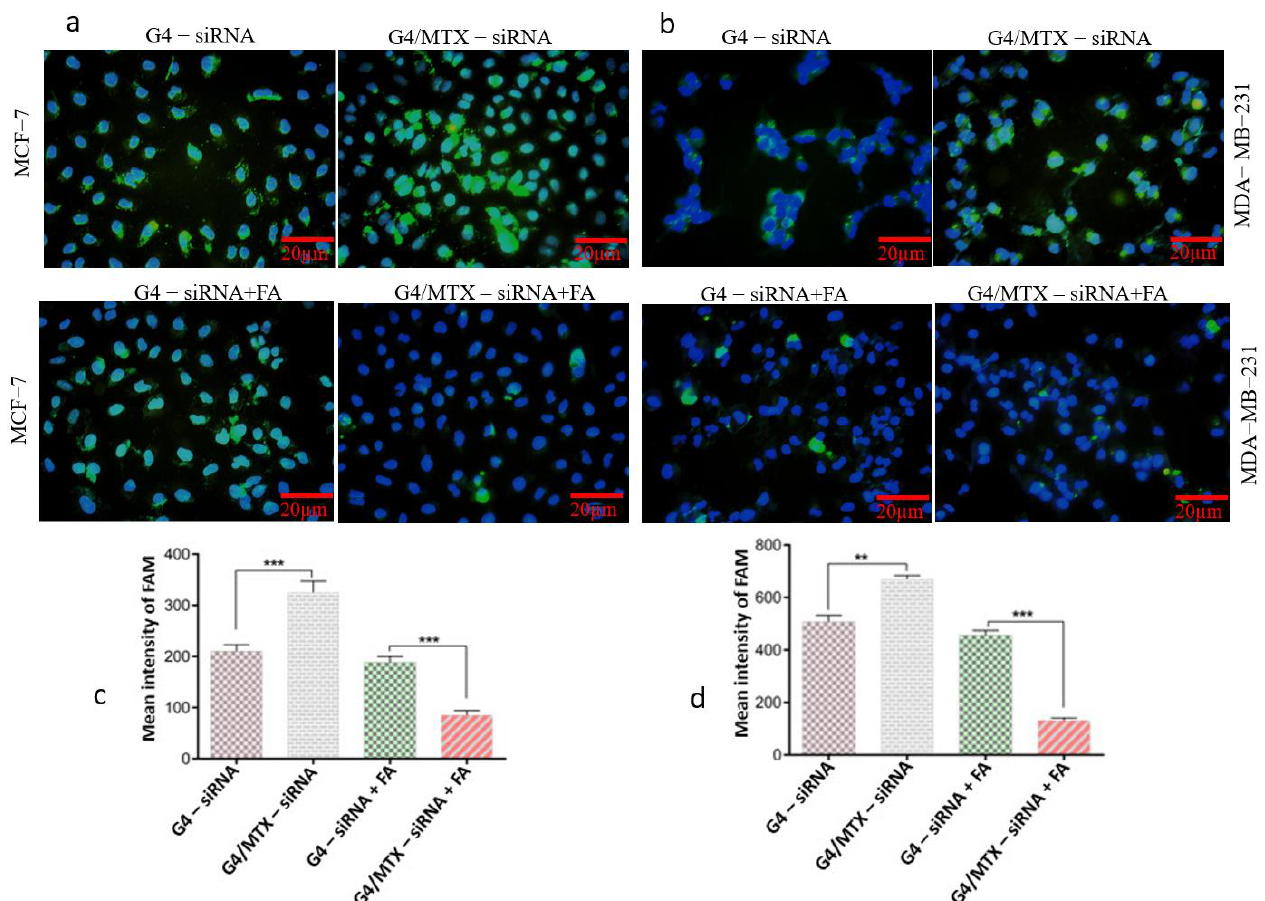
Figure 3. Intercellular uptake of FAM—labeled siRNA in complexing with G4 dendrimer and G4/MTX nanosystem by FR expressing cancer cells. Intercellular localization of fluorescence-labeled G4-siRNA and G4/MTX-siRNA in MCF-7 cells ( a ) and MDA-MB-231 ( b ) cells in the absence and presence FA (1 mM) for 4 h that were imaged by fluorescence microscopy (scale bar 20 µm). Blue and green represent DAPI stained nucleus and FAM — labeled siRNA respectively. MFI quantified cellular uptake in the absence and presence FA (1 mM) for MCF-7 cells ( c ) and MDA-MB-231 cells ( d ) when cells were treated with FAM — labeled siRNA in complexing with G4 dendrimer and G4/MTX nanosystems. The data were expressed mean ± SD ( n = 3). Significance: ** p values < 0.01; *** p values < 0.001.